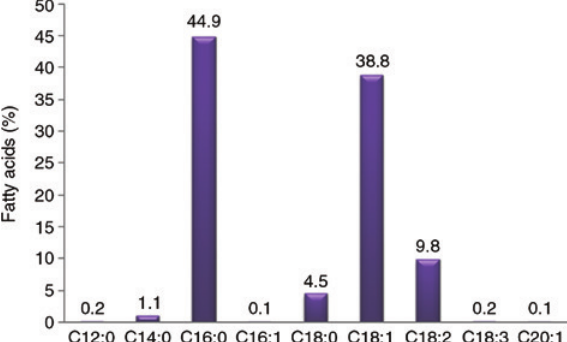
Figure 1: Palm oil fatty acids profile.